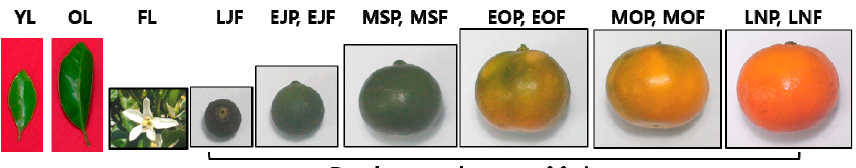
Figure 1. Photographs of leaves, flower, and fruits of C. unshiu at different stages of development. (YL, young leaf; OL, old leaf; FL, flower; LJF, late June fruit; EJP and EJF, early July peel and flesh; MSP and MSF, middle September peel and flesh; EOP and EOF, early October peel and flesh; MOP and MOF, middle October peel and flesh; LNP and LNF, late November peel and flesh).